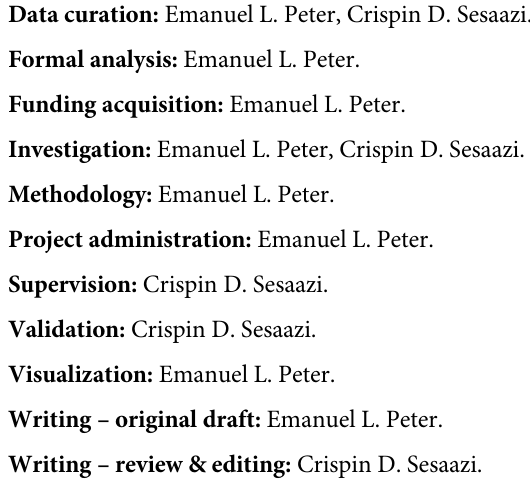
S3 Table. Weight variation of DM083